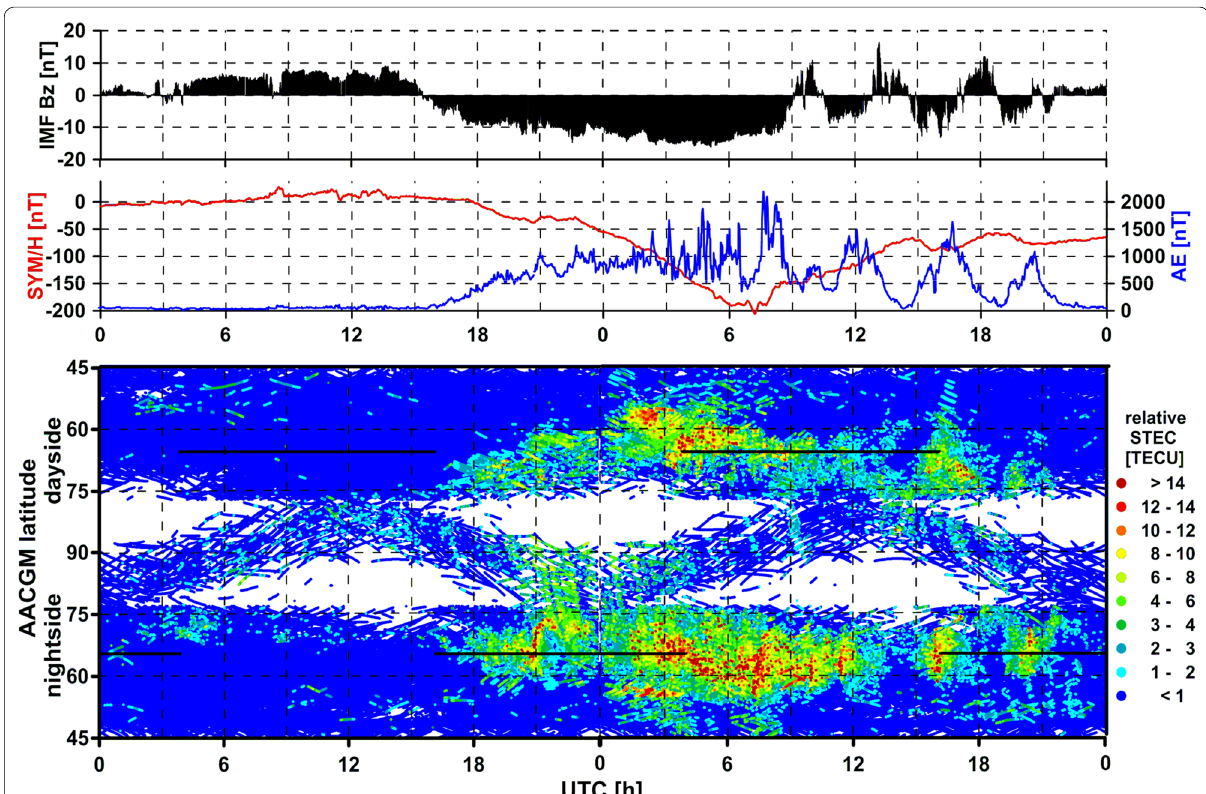
Fig. 2 The relative STEC values on day- and nightside ionosphere during geomagnetic event on August 25–26, 2018. Top panels present the corresponding variations of IMF Bz, SYM/H and AE indices. Black lines correspond to the latitude of rover receiver for day and nightside periods,